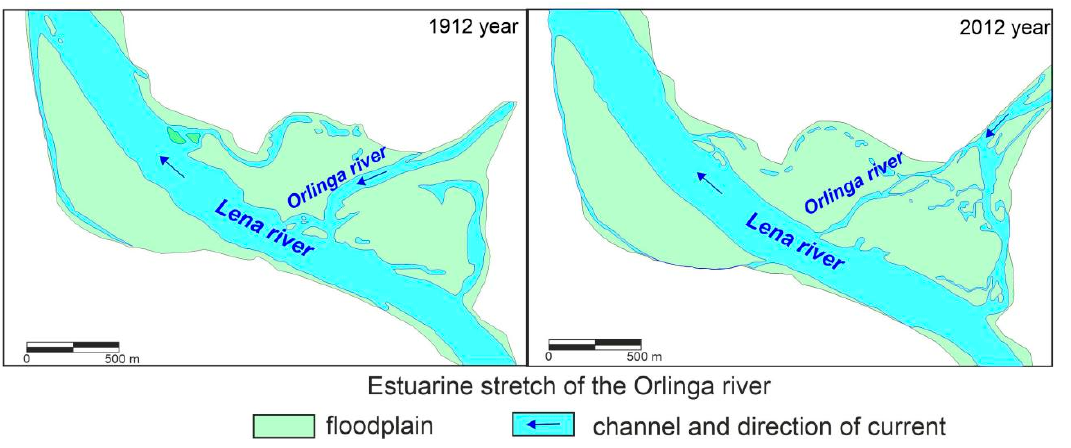
Figure 8. Channel plane deformations of the Lena river.